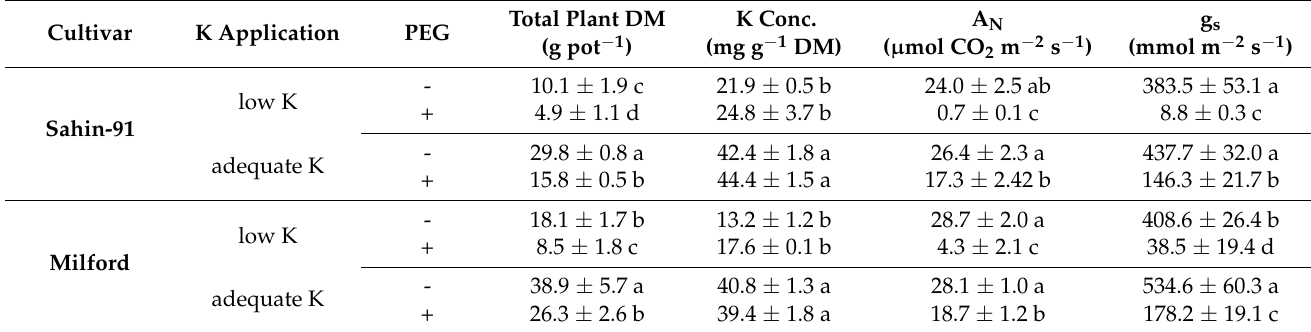
Table 1. Effect of varied K supply on total dry matter (g pot − 1 ), leaf K concentration (mg g − 1 DM) and assimilation rate AN ( µ mol CO 2 m − 2 s − 1 ) of two barley cultivars (Sahin-91 and Milford)